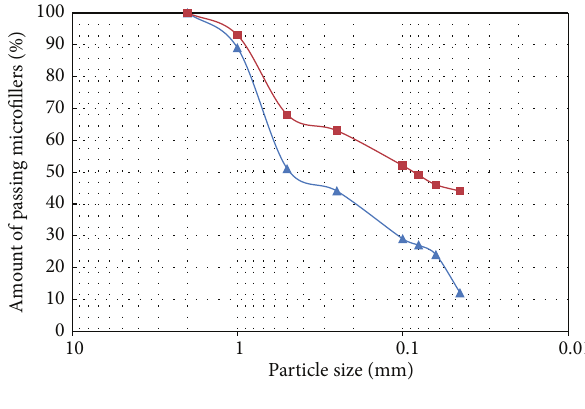
Figure 10: Particle-size distribution of the different microfillers blends used in the PC tested (RBA-11MF and RBA-11).